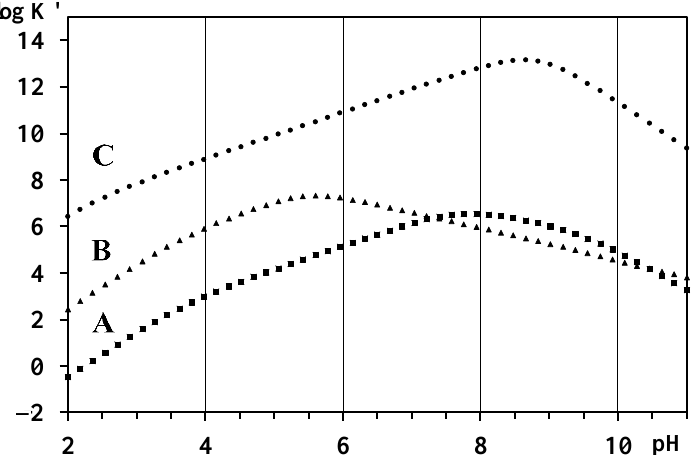
Figure Figure 6. pH dependence of the calculated conditional stability constants (logK’) in the [(η 5 - Cp*)Rh] 2+ –dhp ( A ), [η 6 - p -cym)Ru] 2+ –dhp ( B ) and [(η 5 -Cp*)Rh] 2+ –pic ( C ) systems (t = 25 °C, I= 0.20 M, c L = c M = 5.0 mM) using data from References [33–35].